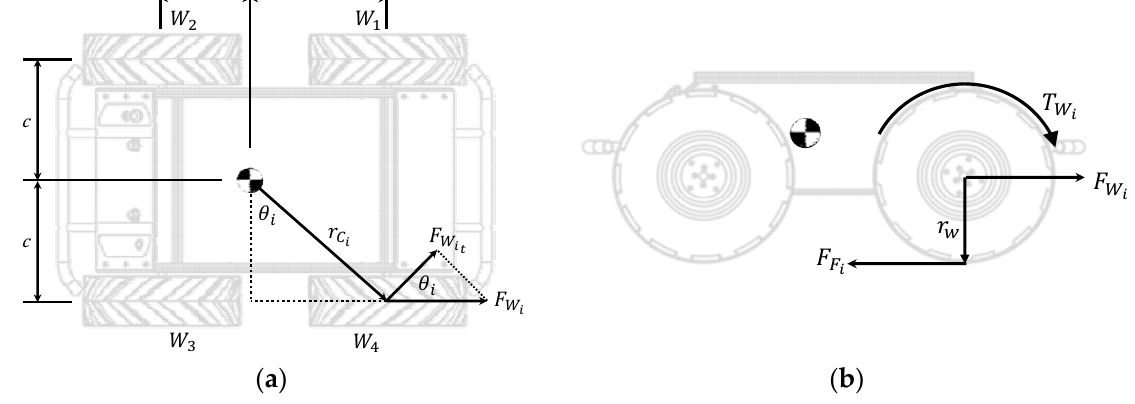
Figure 7. Diagrams of ( a ) vehicle rotational moments and ( b ) wheel tractive forces produced by the torque of the wheels.